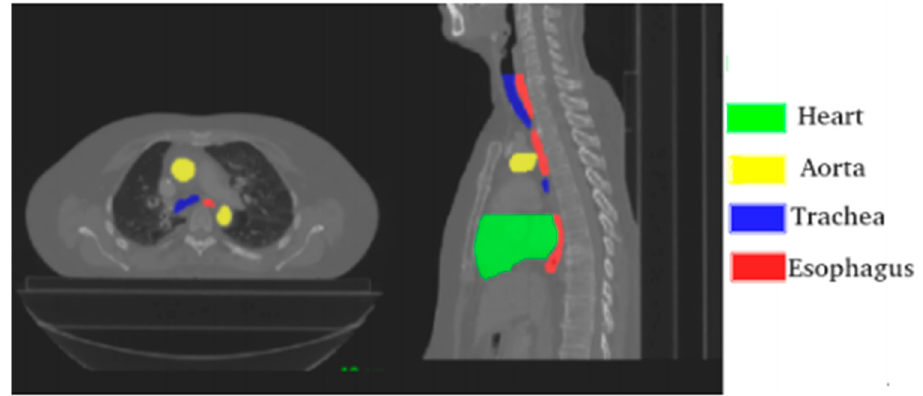
Figure 1. Axial and sagittal planes with annotated organs; source Lambert et al. [39].